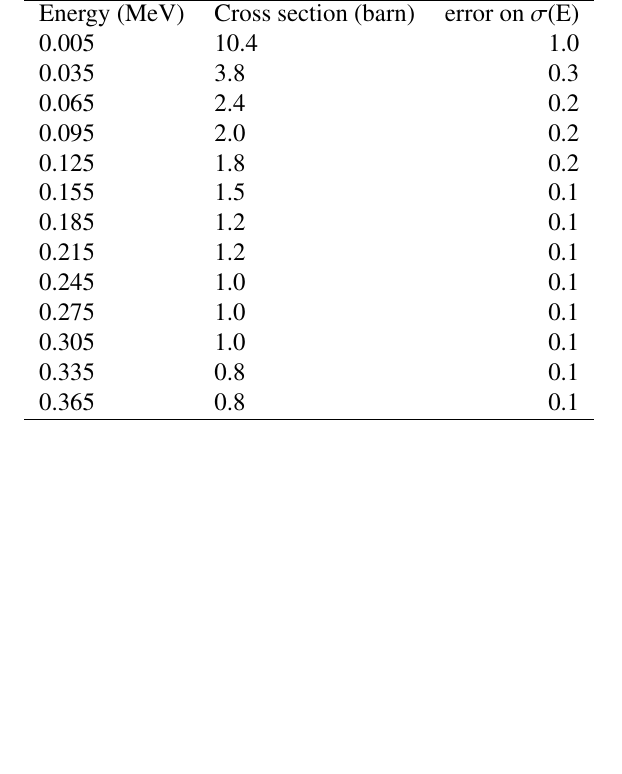
Table 1. Cross section for the process of interest normalized to direct data as discussed in the